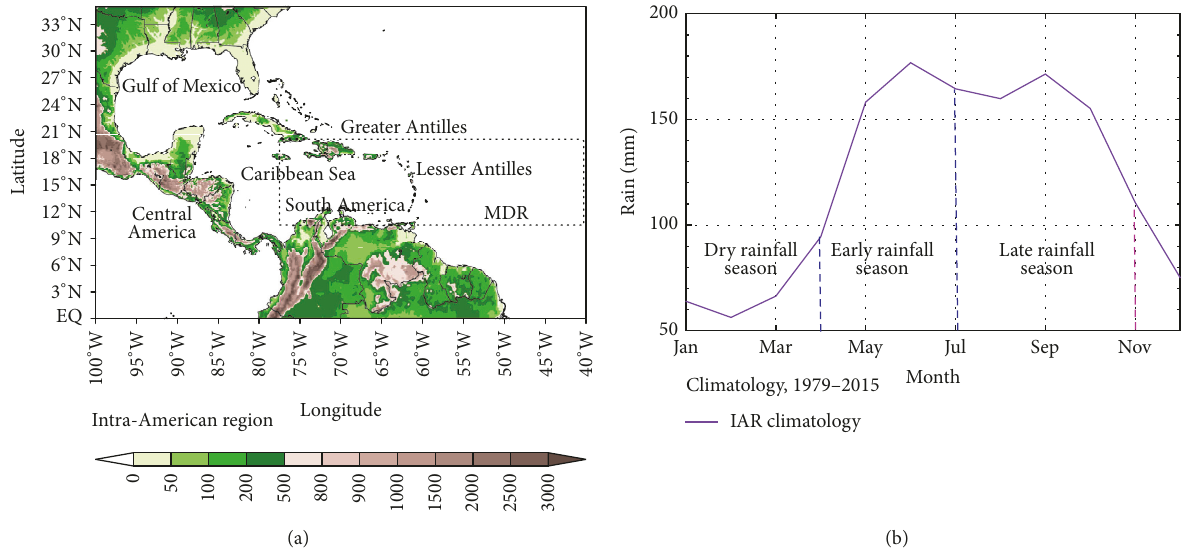
Figure 1: (a) Major areas in the IAR; (b) IAR rainfall bimodal nature showing the DS, ERS, and LRS. The dry season is defined from December to March, corresponding to the season with the lowest rainfall intensity events.